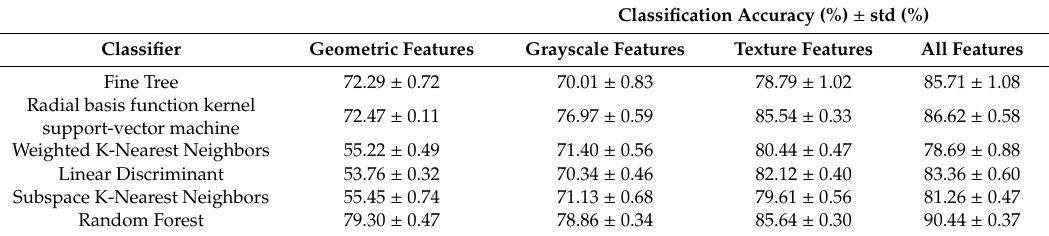
Table 4. Comparing the results of random forest and the other 5 machine learning methods for identifying maceral components (10-fold cross-validation, and repeat the experiment 10